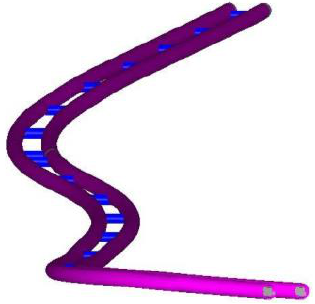
Figure 6 . The 3D model of the